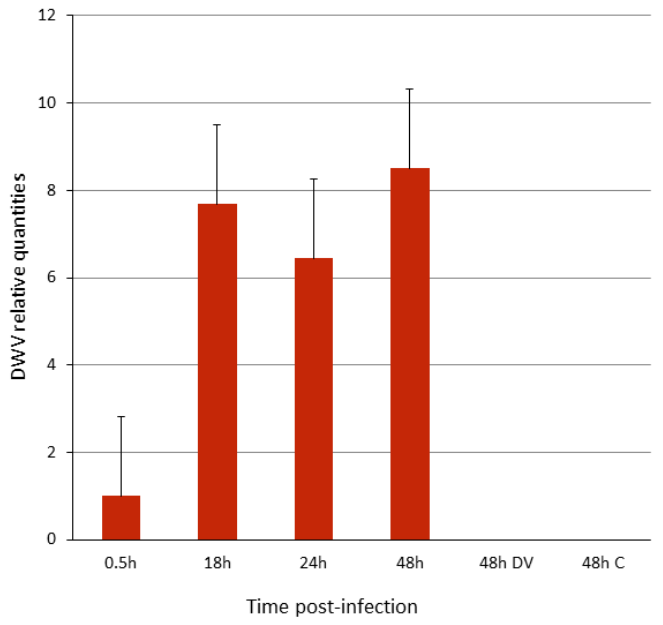
Figure 2. Infection of P1 cells with DWV. Y -axis, relative amount of DWV genomic copies, normalized expression in respect to the virus bound to the cells for 0.5 h of incubation and wash. X -axis, h, hours; DV, heat-inactivated virus inoculum; C, mock-infected cells (see Materials and Methods, Section 2.3). Bars represent standard error values. One-way ANOVA (F = 4.8581, P =